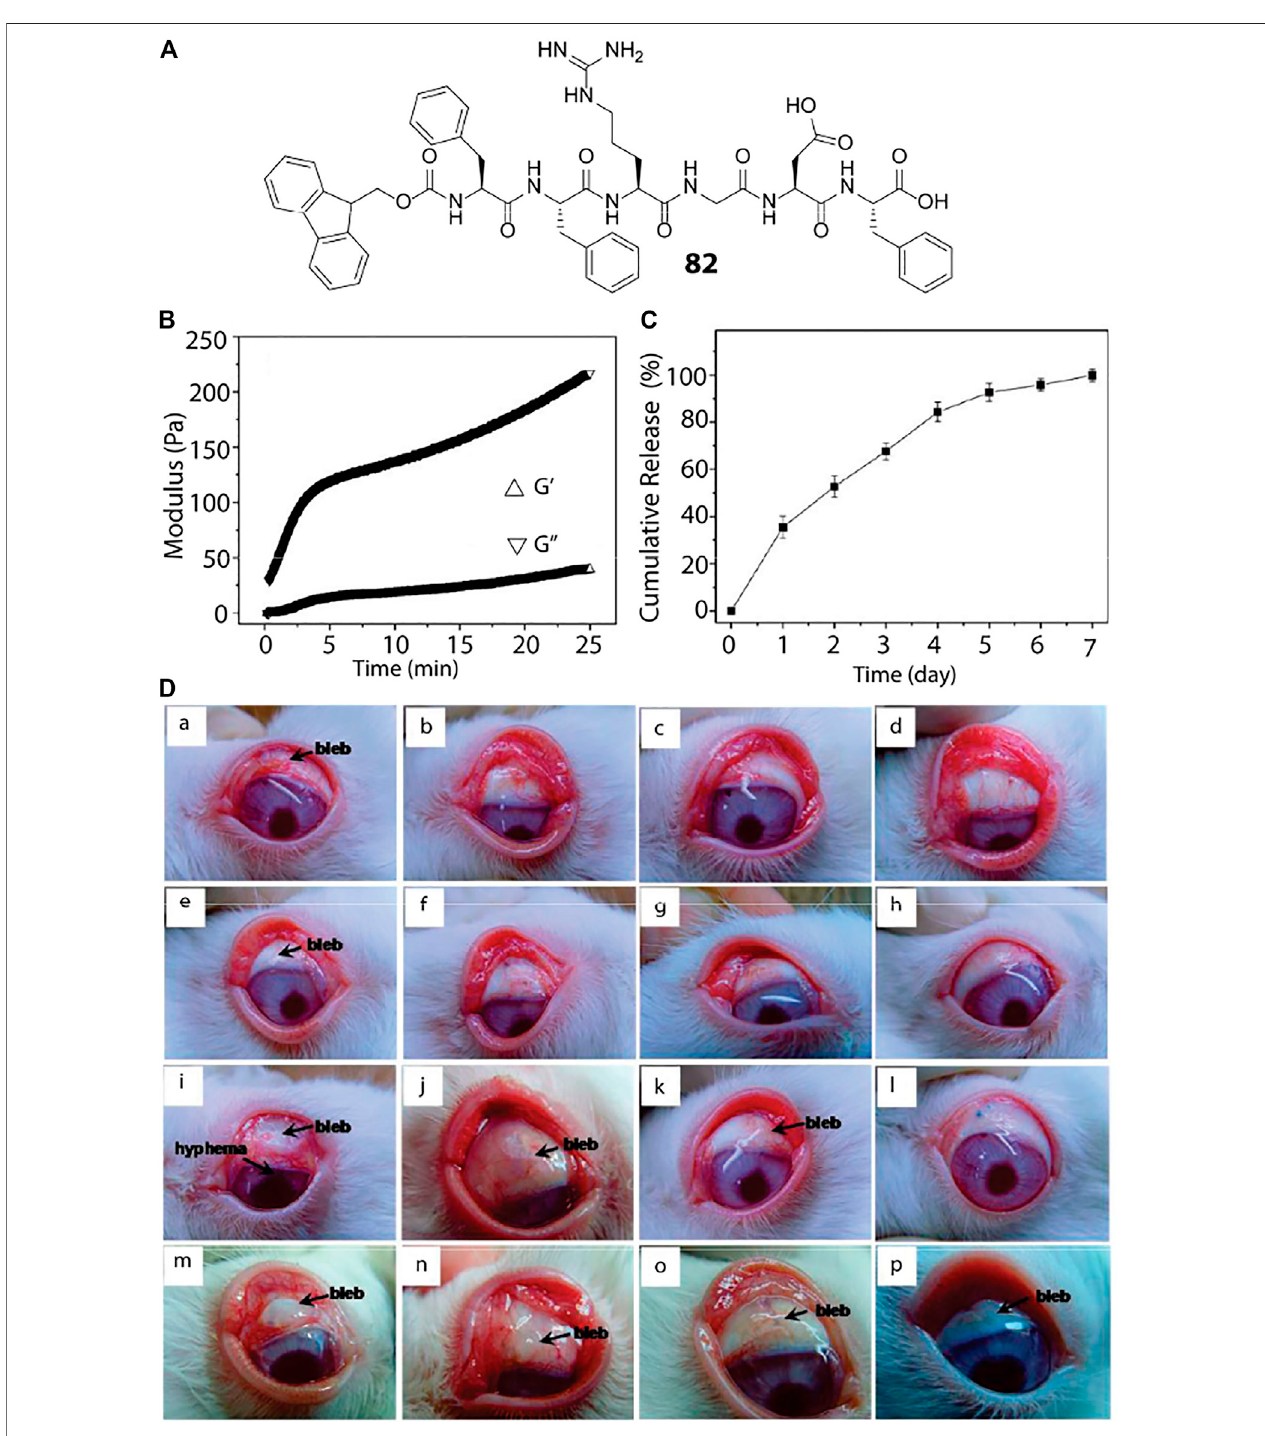
FIGURE 4 | Peptide hydrogel based ocular drug delivery. (A) Chemical structure of the peptide hydrogelator used for ocular delivery of 5-Fu. (B) Oscillatory rheology of the peptide hydrogel where the storage and loss modulus are plotted against time. (C) In-vitro 5-Fu release by the hydrogel under physiological condition showing sustained release of the drug over a period of 7 days. (D) (a – d): Photo imagesof the rabbiteyesthat underwent fi ltering surgery alone at postoperative (a) 7, (b) 14,(c)21,and(d)28 days,respectively;(e – h)photoimagesoftherabbiteyesthatreceivedthepeptidehydrogelatpostoperative(e)7,(f)14,(g)21,and(h)28 days, respectively;(i – l)photo imagesoftherabbiteyesthatexposedto5-Fuintraoperativelyatpostoperative(i)7(j)14(k)21,and(l)28 days,respectively;(m – p)photoimages of the rabbit eyes that received the 5-Fu-loaded peptide hydrogel at postoperative (m) 7 (n) 14 (o) 21, and (p) 28 days, respectively. Reproduced with permission (Xu et al., 2010). Copyright 2010 American Chemical Society.